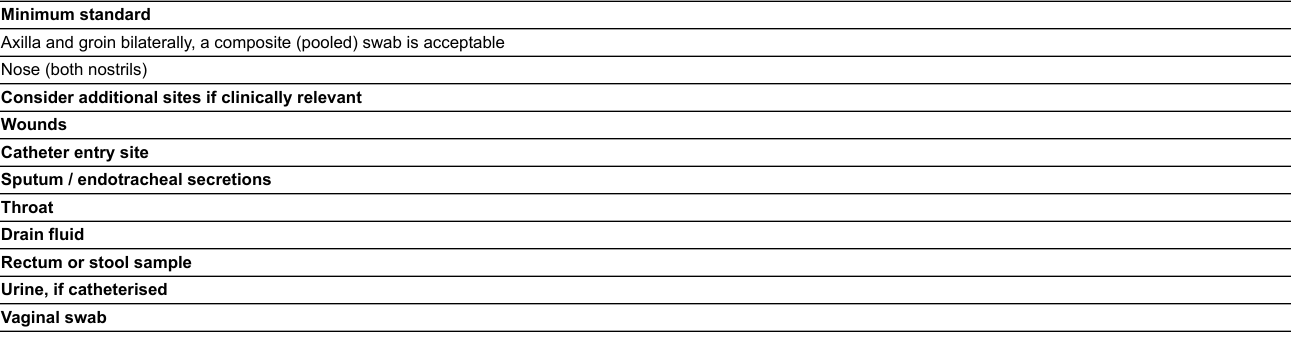
Table 2: Recommended body sites for C. auris screening [15, 17]. Minimum